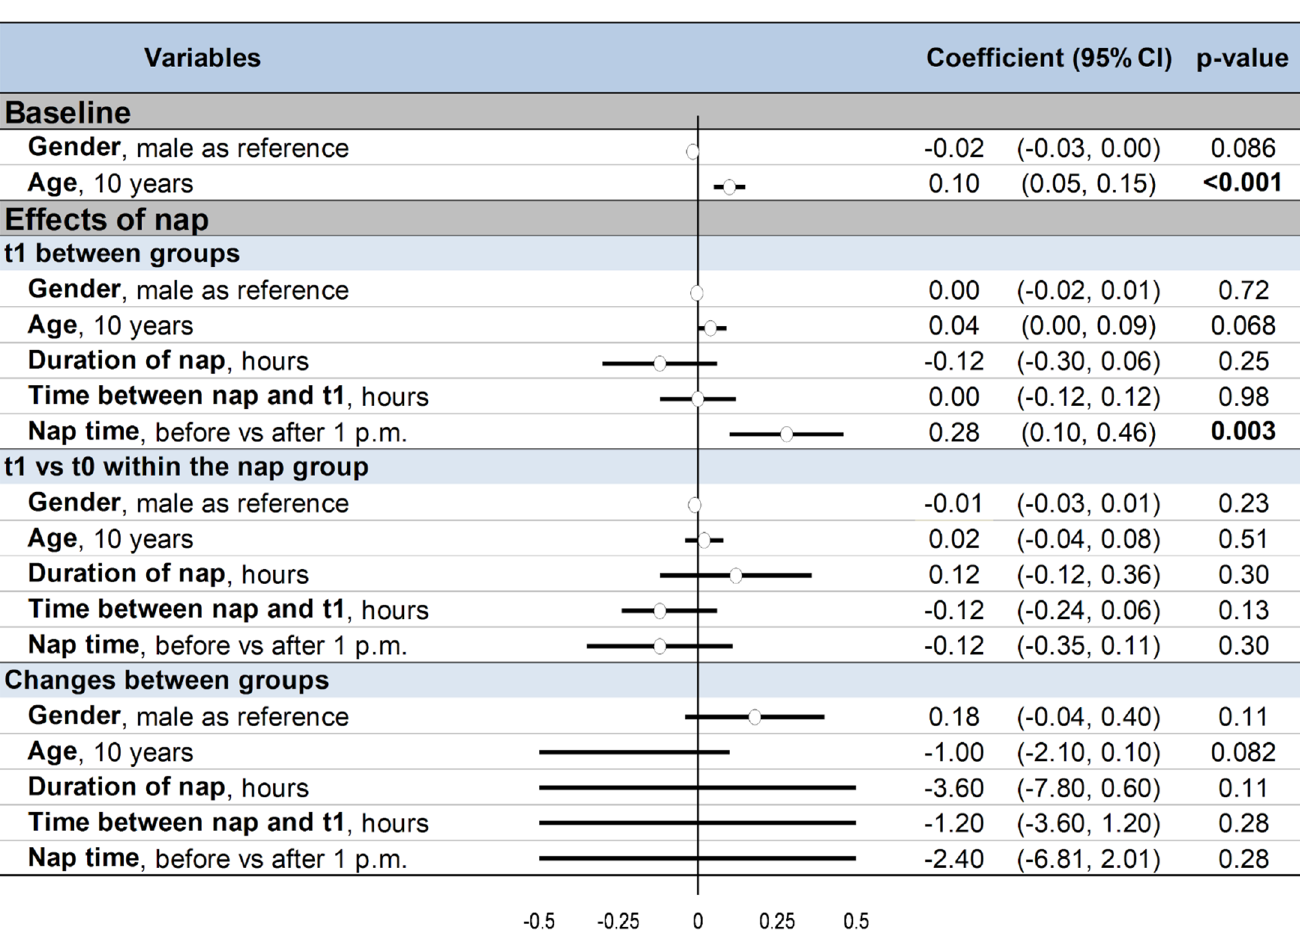
Figure 6. Summary of meta-regressions: 95%CI: 95% confidence intervals; t0: baseline; t1: after nap (nap group) or rest without nap (control group) Results were presented before ( left ) and after ( right ) exclusion of non-randomized controlled trials The effect of each variable on the outcome is represented in the forest-plot by a dot on a horizontal line. The black dots represent the coefficient for each variable, and the length of each line around the dots represents their 95% confidence interval (95CI). The black solid vertical line represents the null estimate (with a value of 0). Horizontal lines that cross the null vertical line represent non-significant variables on the outcome. Bold numbers represent the significant results ( p < 0.05).